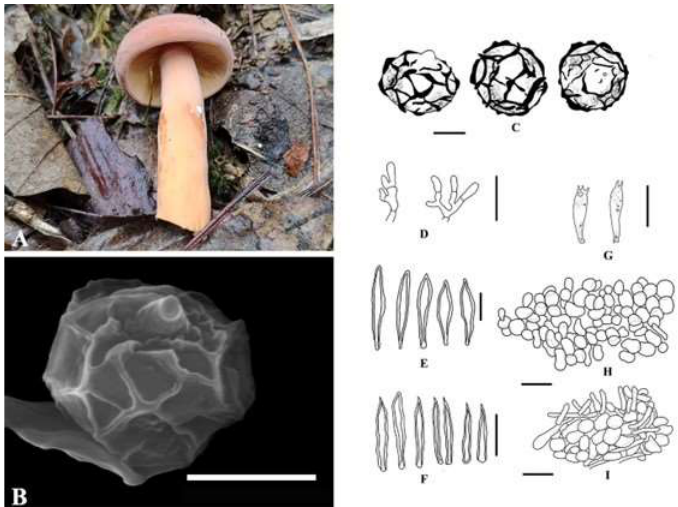
Figure 3. Lactifluus qinggangtangensis microscopic characteristics: ( A ) Fresh basidiomata (holotype). ( B ) SEM microphotographs. ( C ) Basidiospores. ( D ) Marginal cells. ( E ) Pleurocystidia. ( F ) Cheilocys- tidia. ( G ) Basidia. ( H ) Stipitipellis. ( I ) Pileipellis. Scale bars: 4 µm ( B ), 3 µm ( C ), and 30 µm ( D – I ). Pilei are 24.12–52.73 mm diameter and are slightly concave in the center to convex to planoconvex with a broadly depressed center. Velvet is mainly distributed on the edge, and orange (W3C) (#FFA500) is in the center when young, gradually becoming applanate to infundibuliform or concave; the surface is smooth, dry, and velvety, with an uneven distribution. The edge bends inward and is integral and brittle in consistency. Lamellae are decurrent, white (W3C) to cream (#FFFFCC), thick and brittle, and dense; the edge is concolorous to marginate. The attachment to the stipe varies from adnate to adnate with a decurrent tooth to decurrent and is milk white (#FEFCFF) after bruising, with no discol-